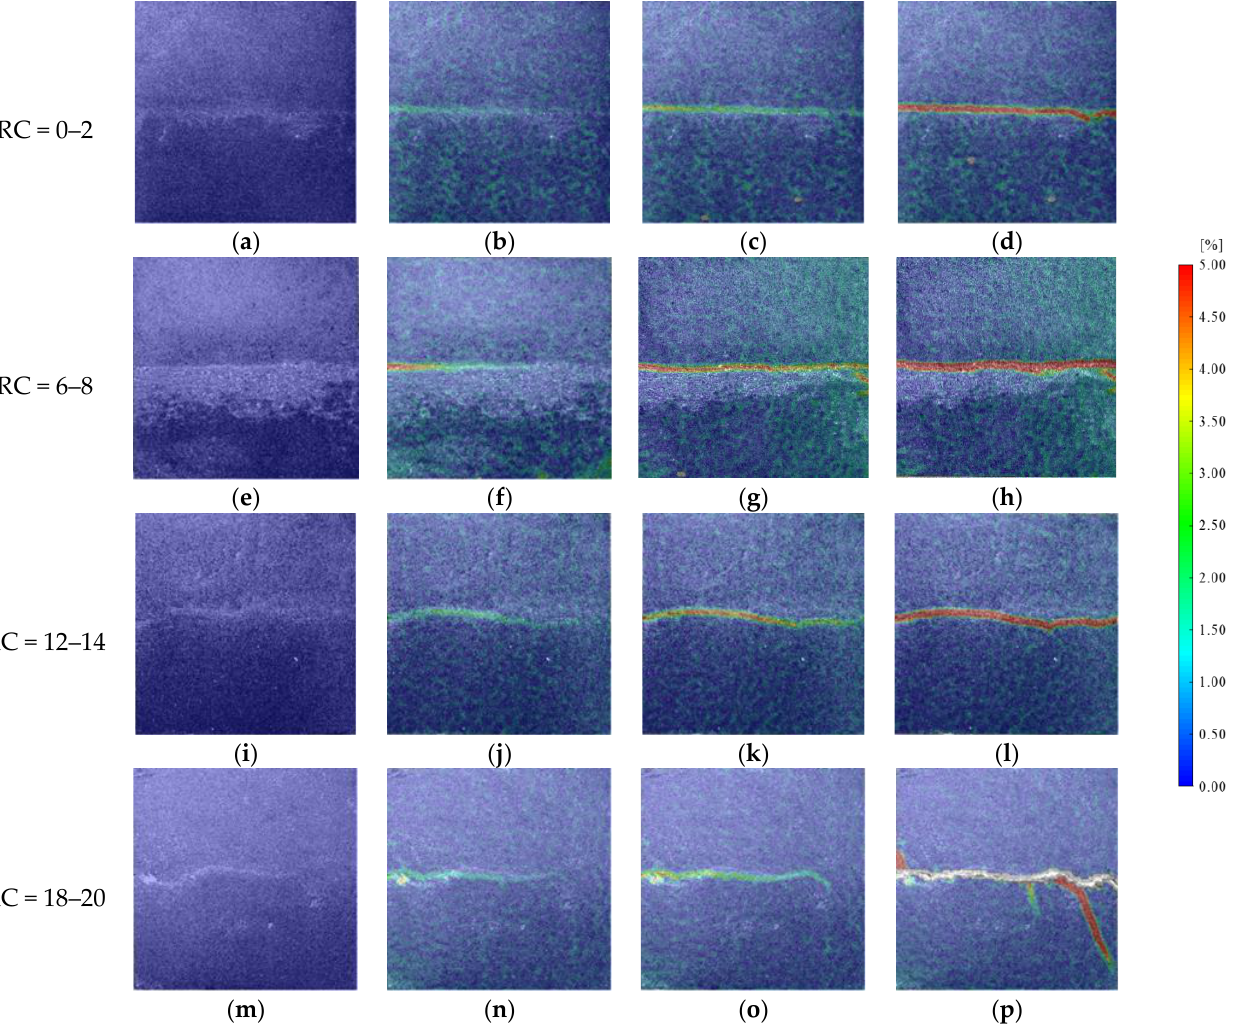
Figure 8. Principal strain field of specimens at different JRC. ( a ) Frame 0. ( b ) Frame 389. ( c ) Frame 672. ( d ) Frame 943. ( e ) Frame 0. ( f ) Frame 682. ( g ) Frame 1267. ( h ) Frame 1962. ( i ) Frame 0. ( j ) 942. ( k ) Frame 1846. ( l ) Frame 2740. ( m ) Frame 0. ( n ) Frame 1253. ( o ) Frame 2158. ( p ) Frame